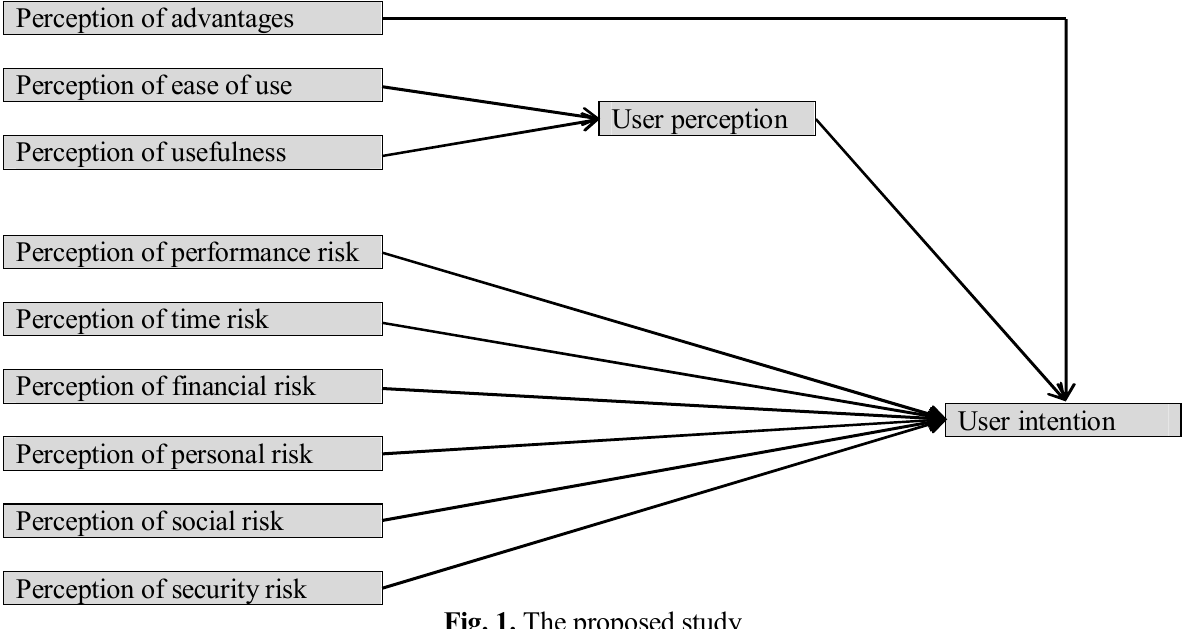
Fig. 1. The proposed